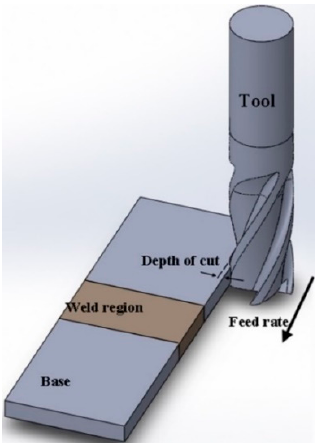
Figure 4. Schematic design of cutting process for welded specimens. Table 2. Specifications of end mill tool.